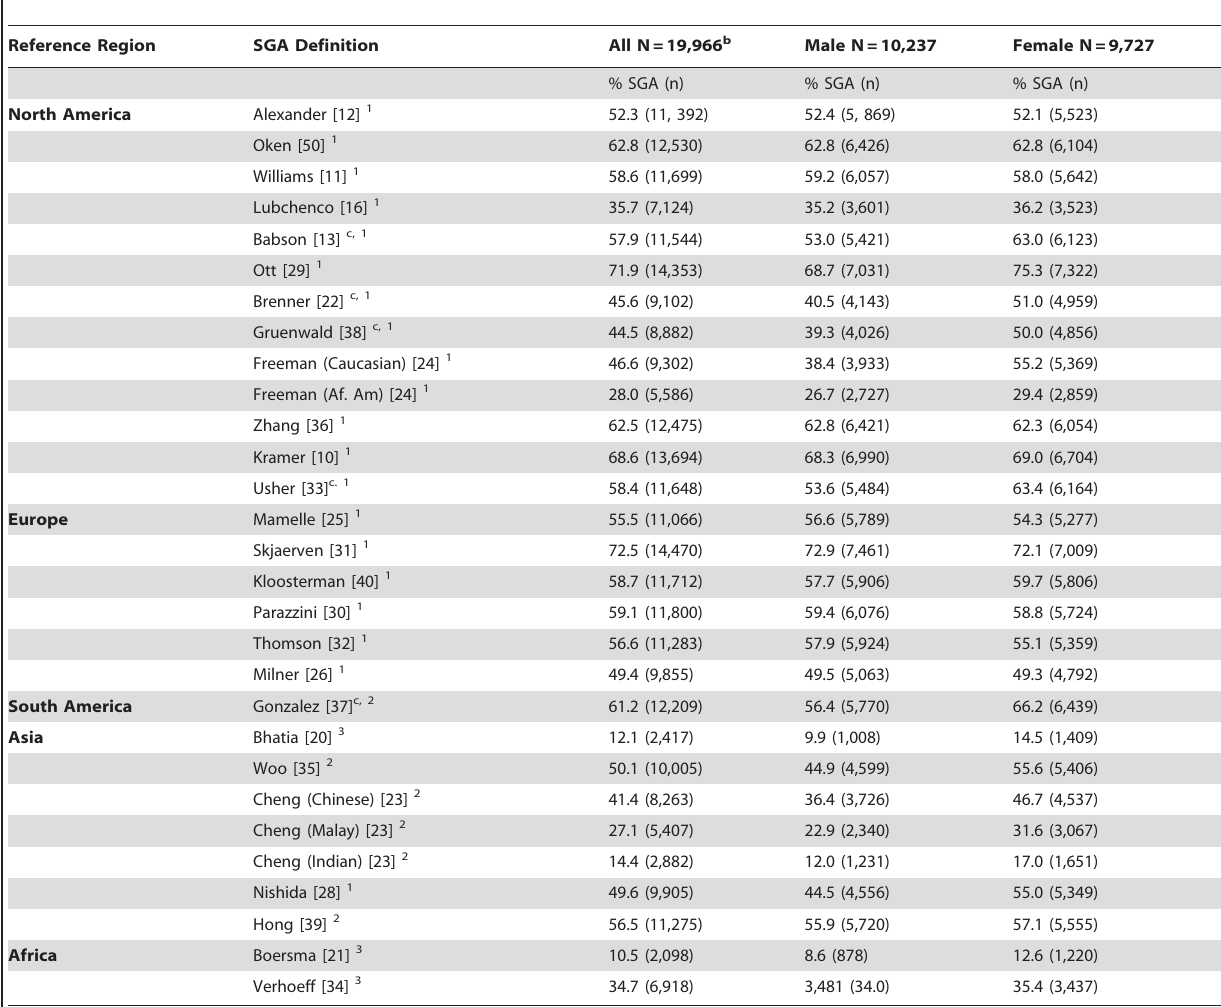
Table 2. Prevalence of Small-for-Gestational Age (SGA) in Southern Nepal using Reference Populations from Five Regions [17] a .